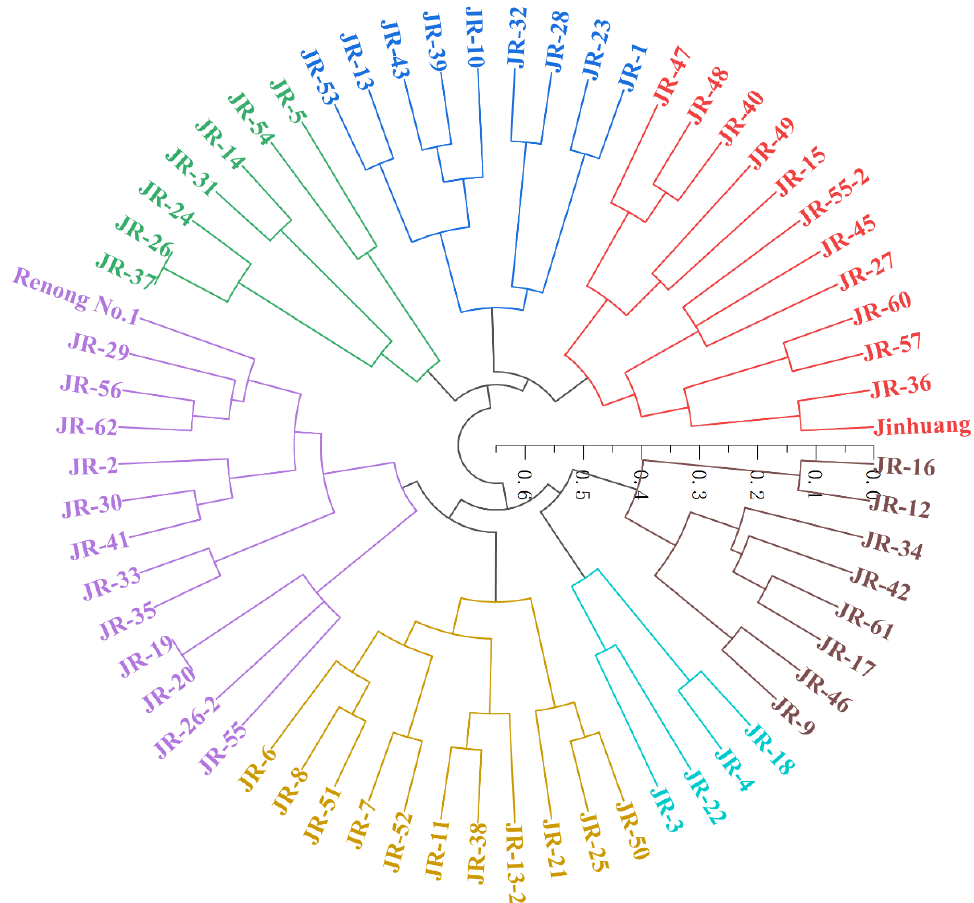
Figure 4. Dendrogram of parents and progenies of ‘Jinhuang’ × ‘Renong No.1’ derived from UPGMA cluster analysis based on eight SSRs makers. Different colors represent offsprings clustered in different categories.